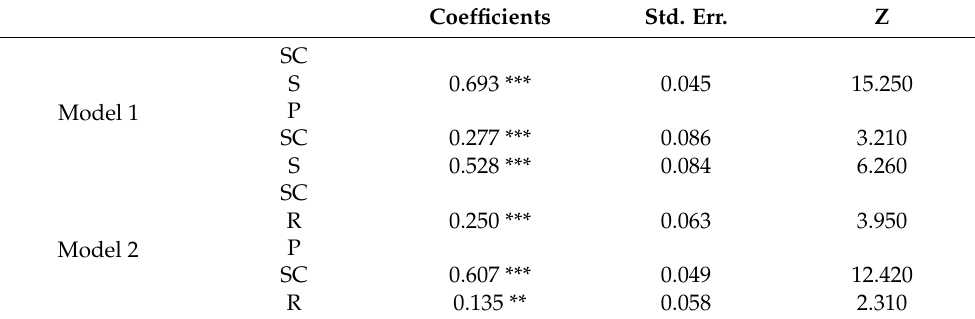
Table 4. Summary of the